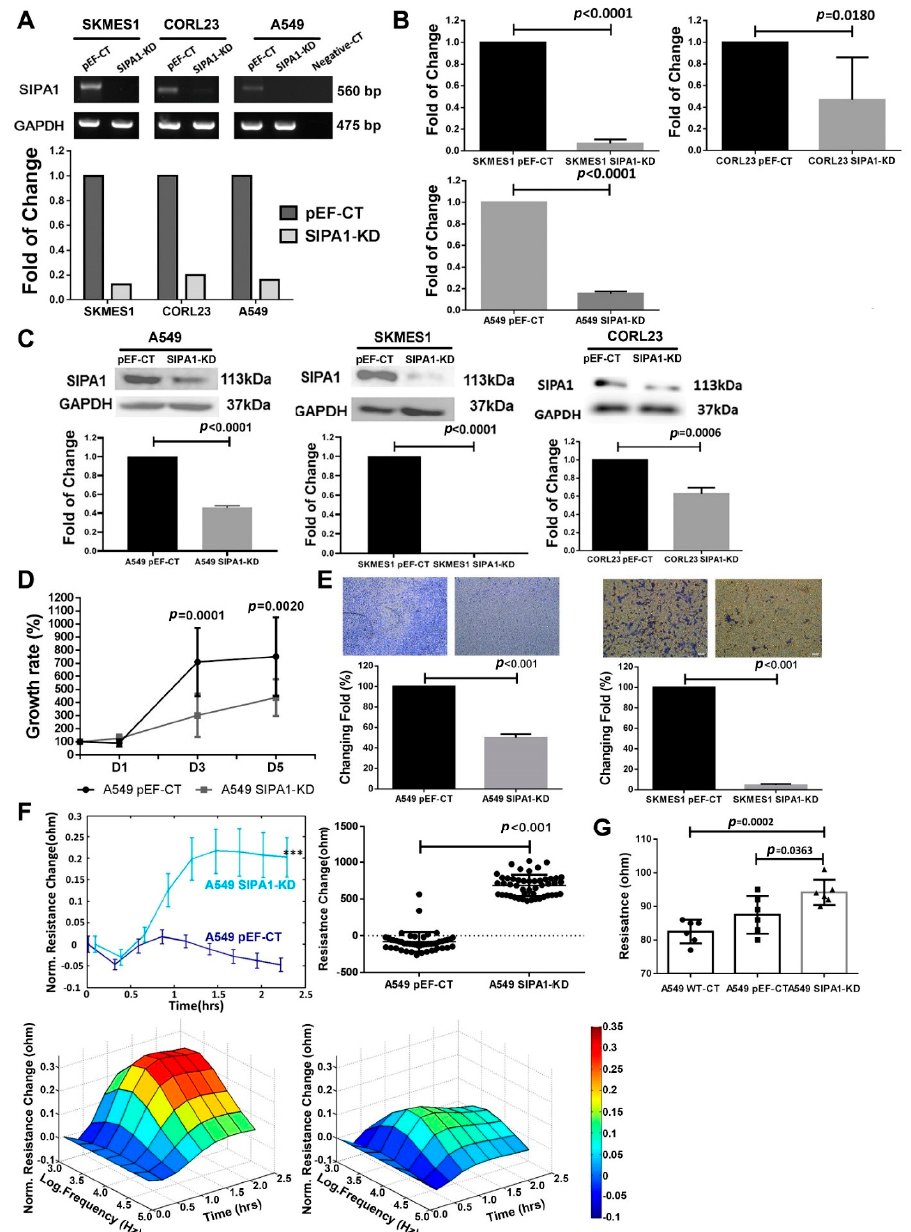
Figure 3. Knockdown of SIPA1 and its effect on the aggressive behaviour and barrier function of lung cancer cells. Verification of the knockdown of SIPA1 in SKMES1, CORL23 and A549 cell lines at mRNA level using PCR ( A ), qPCR ( B ) and at protein level using western blotting ( C ). ( D ) Knockdown of SIPA1 decreased the growth of the A549 cells significantly. Error bars show SD. ( E ) Knockdown of SIPA1 decreased the invasion of the A549 and SKMES1 cells significantly. ( F ) Knockdown of SIPA1 increased the resistance of the monolayer of the A549 cells significantly (upper left); quantitative analysis of the resistance at time point 2.5 h showed resistance (and TJ barrier function) of A549 cells was upregulated (upper right); recording the resistance of the cells under different electric current frequency to draw the 3D figure showed knockdown of SIPA1 increased the cell-cell tight junction barrier function (lower). ( G ) Changes in Transepithelial Resistance (TER) due to SIPA1 knockdown in A549 cells. Experiments were repeated n = 3. Asterisks indicate statistical